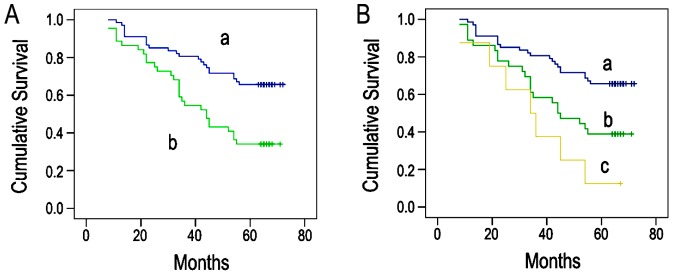
Kaplan–Meier analysis showing overall survival among NSCLC patients.(A) a.the group with IQGAP1 and Dvl noncoexpression in the cytoplasm and nucleus (61 cases); b.the group with IQGAP1 and Dvl coexpression in the cytoplasm and nucleus (50 cases) (B) a.the group with IQGAP1 and Dvl noncoexpression in the cytoplasm and nucleus (61 cases); b.the group with IQGAP1 and Dvl coexpression in the cytoplasm (42 cases); c.the group with IQGAP1 and Dvl coexpression in the nucleus (8 cases).